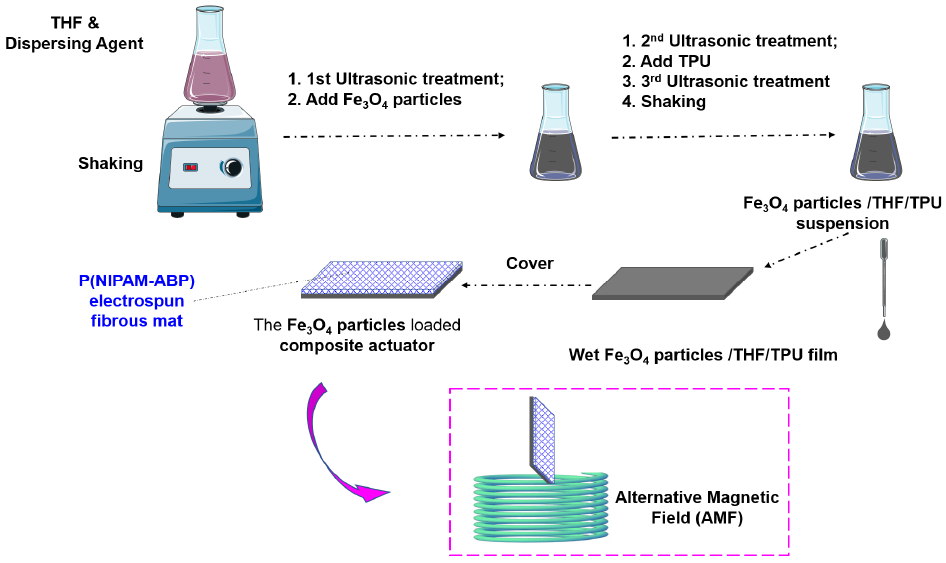
Figure 1. Schematic of the composite actuator fabrication process.